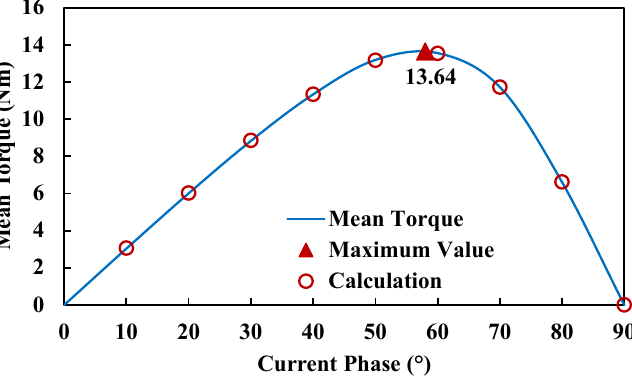
Figure 9. Average torque, calculation values vs. current phases when 50 A is applied.